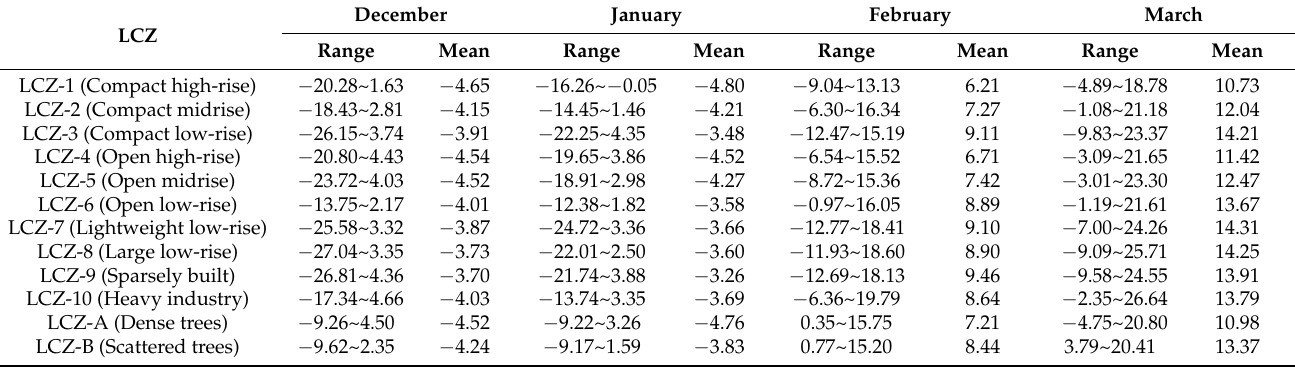
Table 3. Land surface temperature of different local climate zones in different months from 2018 to 2020 ( ◦ C). LCZ LCZ-1 (Compact